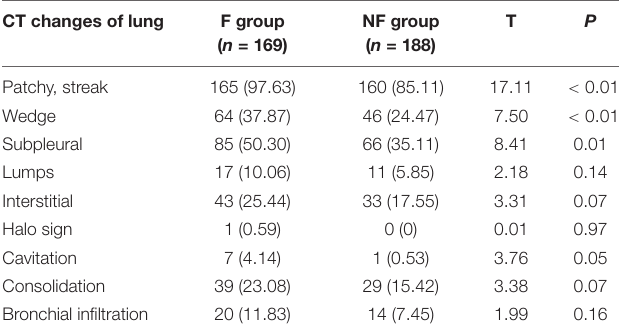
TABLE 7 | Comparison of the chest CT characteristics between groups.